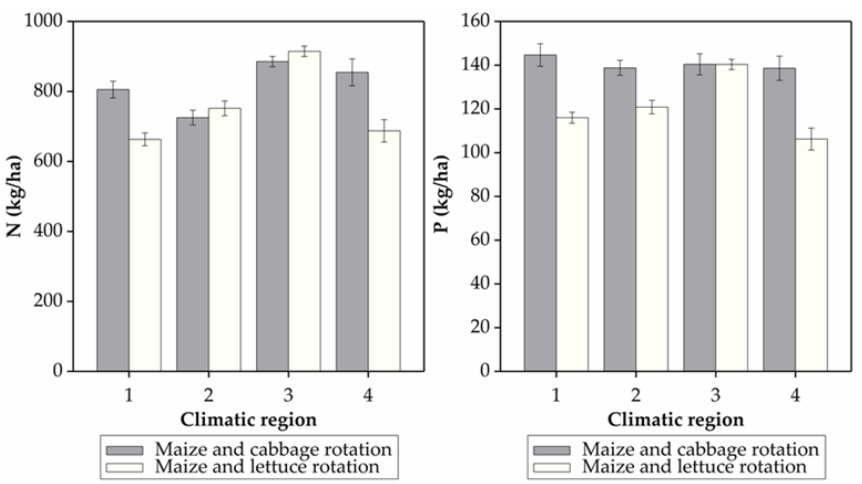
Figure 5. Simulated nitrogen (N), phosphorus (P) and potassium (K) (mean ± standard error of mean deviation; n = 72) applied through irrigation using DEWATS effluent to three crops on four different soil types. 1; Climatic region 1, 2; Climatic region 2, 3; Climatic region 3 and 4; Climatic region 4.